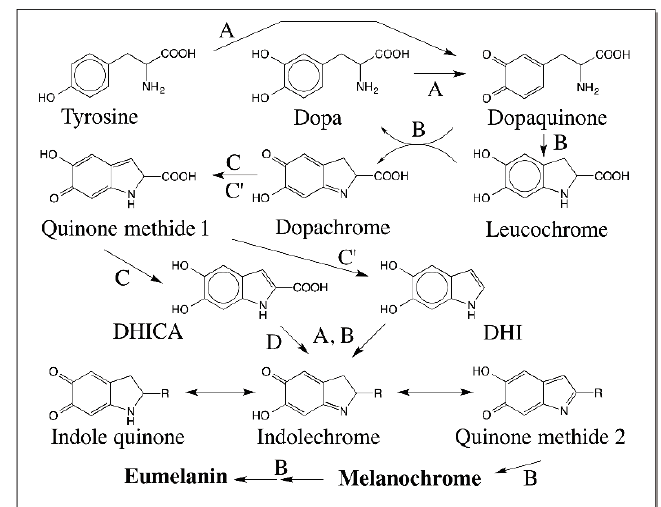
Figure 27. Modified Raper–Mason Pathway for eumelanin biosynthesis. Tyrosinase ( A ) converts tyrosine to dopaquinone and oxidizes dopa to dopaquinone. External addition of cysteine to